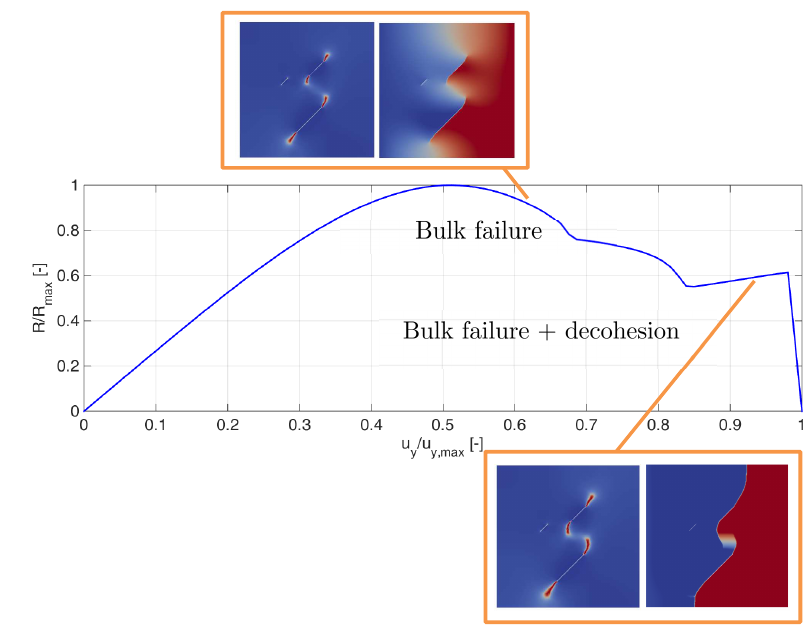
Figure 17. Specimen with 3 inclined flaws and a horizontal joint. Load-displacement evolution curve including snapshots of the bulk (phase field) failure and the horizontal displacement fields.